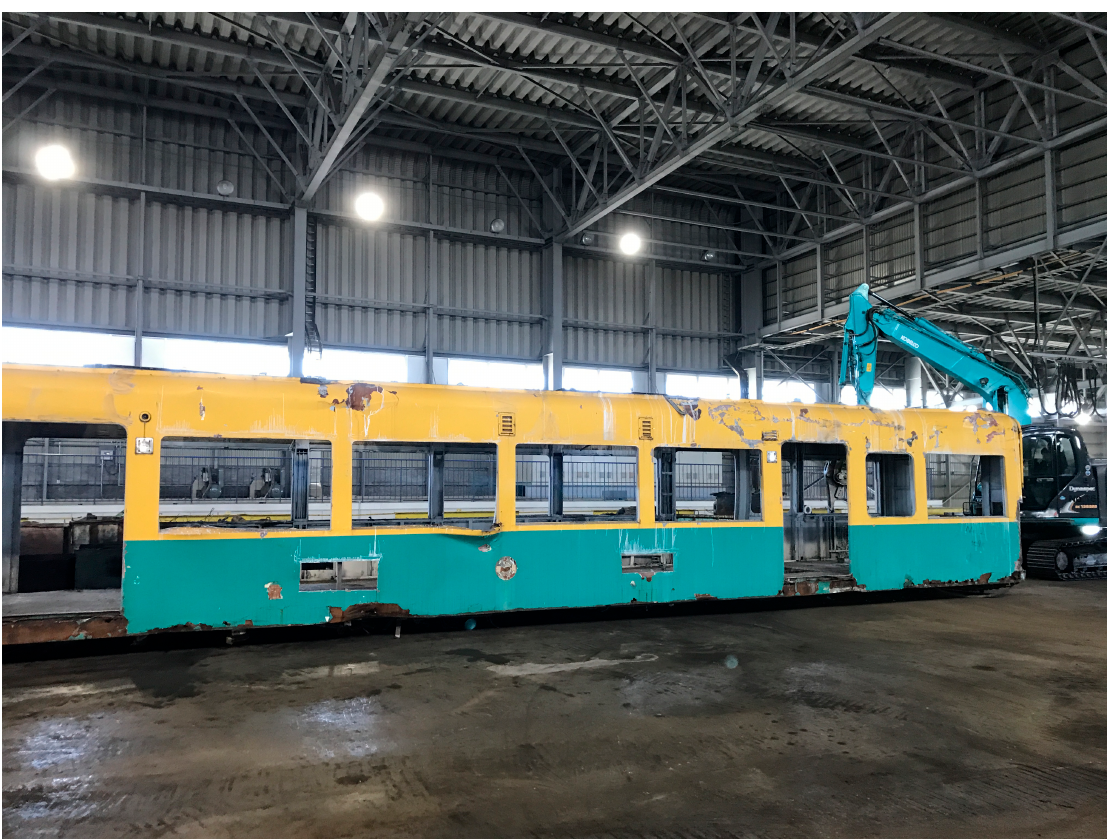
Figure 5. Clockwise from left: corroded internal door pillar; floor plate corrosion; corroded kick plate; cracked external door.